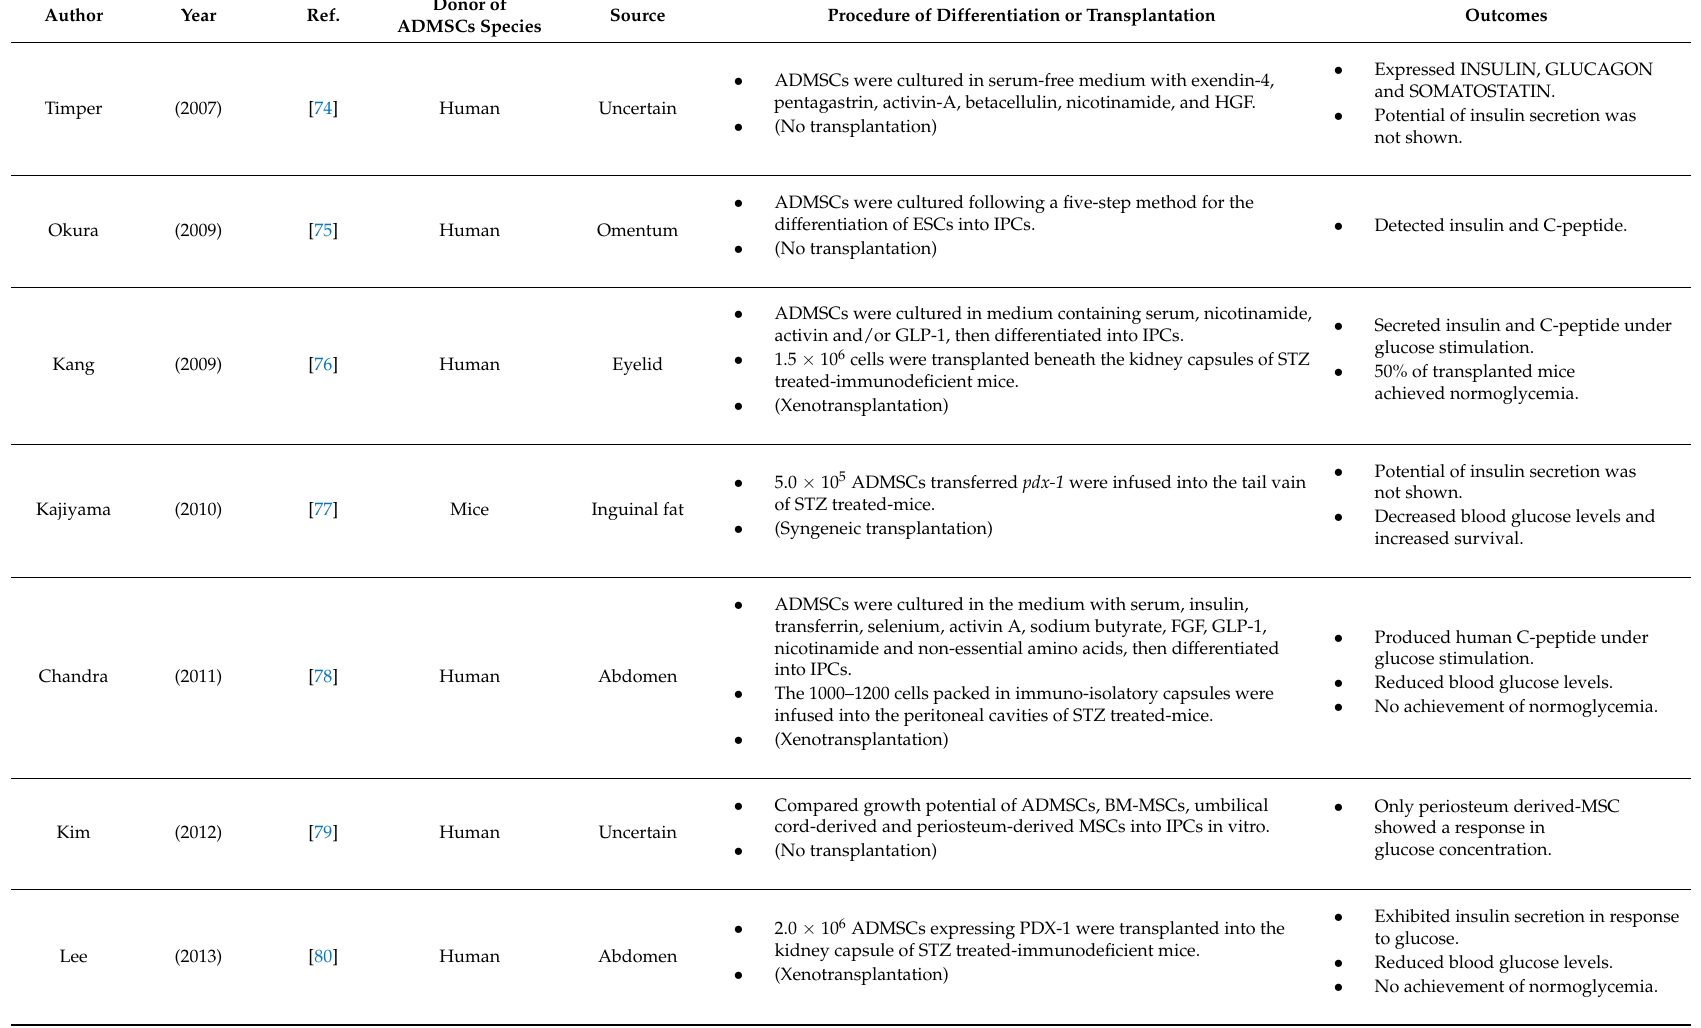
Table 1. Representative studies pertaining to insulin-producing cells (IPCs) differentiated from adipose tissue-derived mesenchymal stromal cells (ADMSCs).